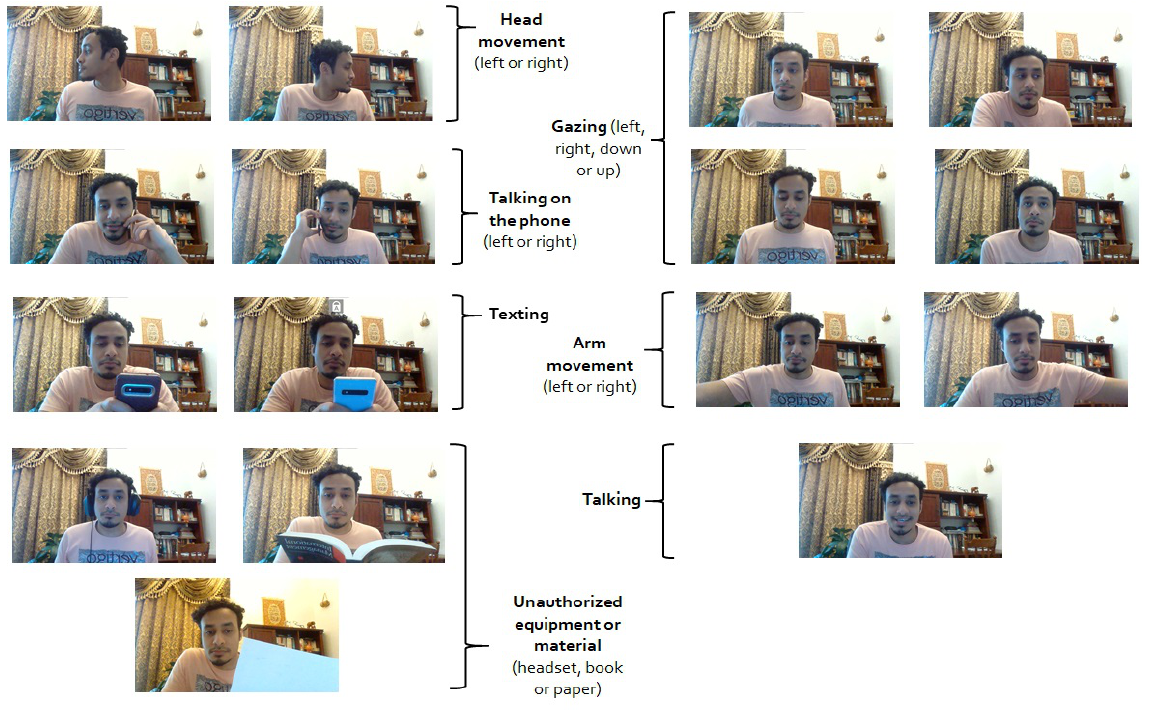
Figure 8. Cheating events detected by the